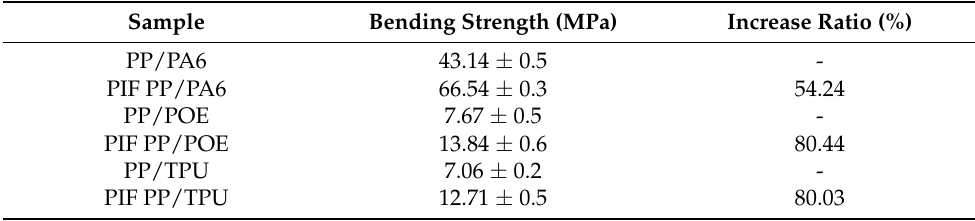
Figure 6. Bending properties of blends before and after PIF, ( A ) PP and PIF PP, ( B ) PP/PA6 and PIF PP/PA6, ( C ) PP/POE and PIF PP/POE, ( D ) PP/TPU and PIF PP /TPU. Table 5. Bending strength and Increase ratio of blended